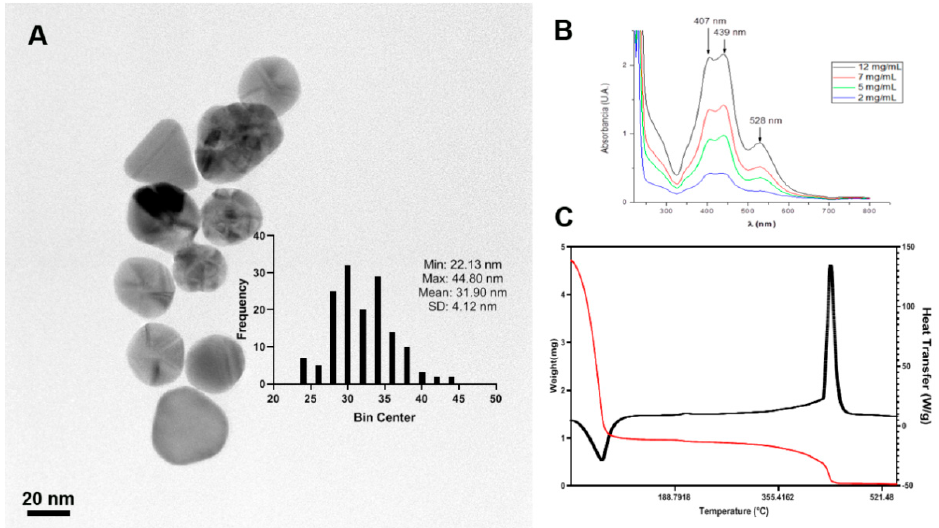
Figure 2. Physicochemical properties of AgNPs. ( A ) TEM images showing AgNPs morphology and size distribution (inset histogram), ( B ) surface plasmon registered at different concentrations in distilled water, and ( C ) DSC/TGA analysis showing the mass loss as a function of temperature increase (red line) and the endothermic/exothermic processes (black line).